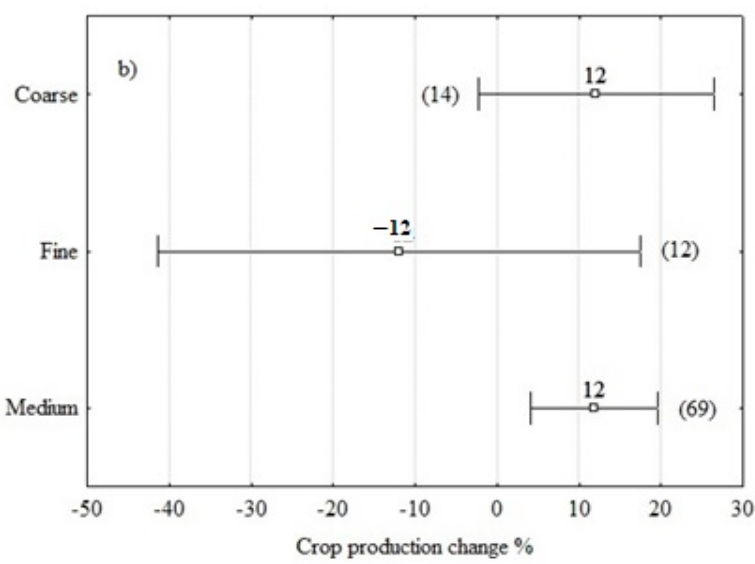
Figure 4. Mean plot of crop production change (%) of crop diversification vs. control management (monoculture) grouped by: ( a ) rotation length and main diversification groups, ( b ) soil texture. Box—Whisker plots represent central point means, and 95% confidence interval. Numbers in brackets represent the number of comparisons used in each category. Coarse (sandy loam, sandy clay loam, loamy sand), Fine (clay, silt clay, sandy clay), Medium (clay loam, loam, silty clay loam, silt, silt loam).